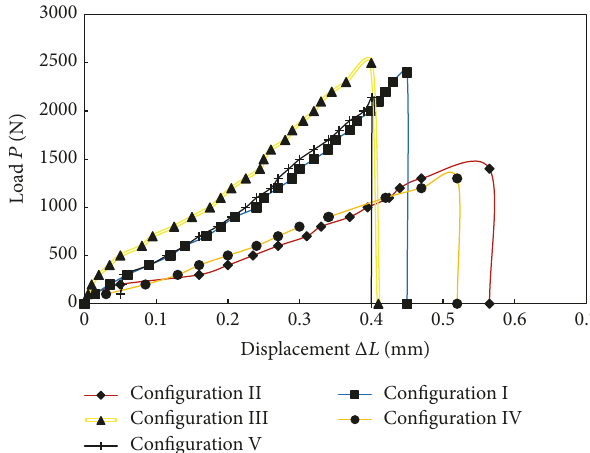
Figure 4: Tensile curves of lontar fiber-reinforced composites with different hole configurations.